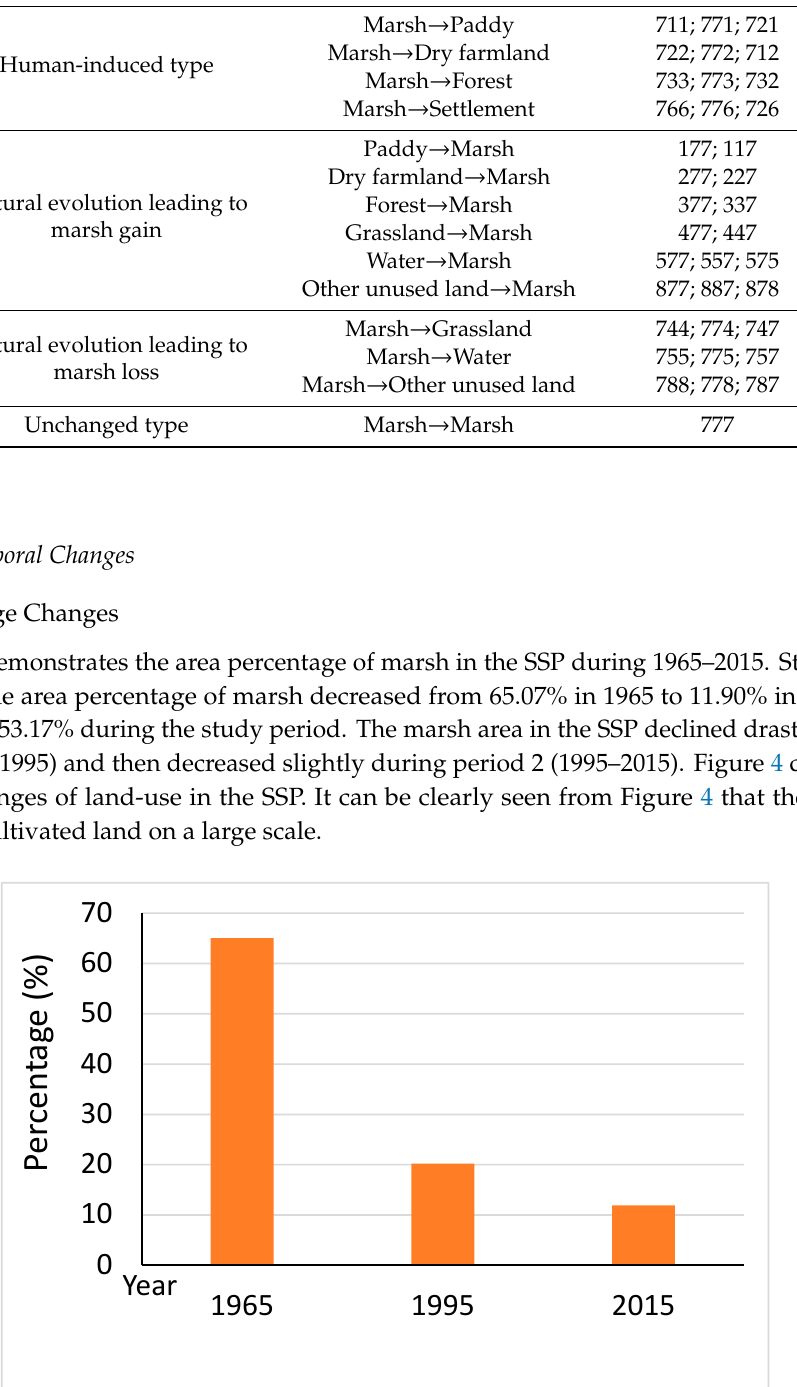
Table 3. Land-use change types related to marsh changes.